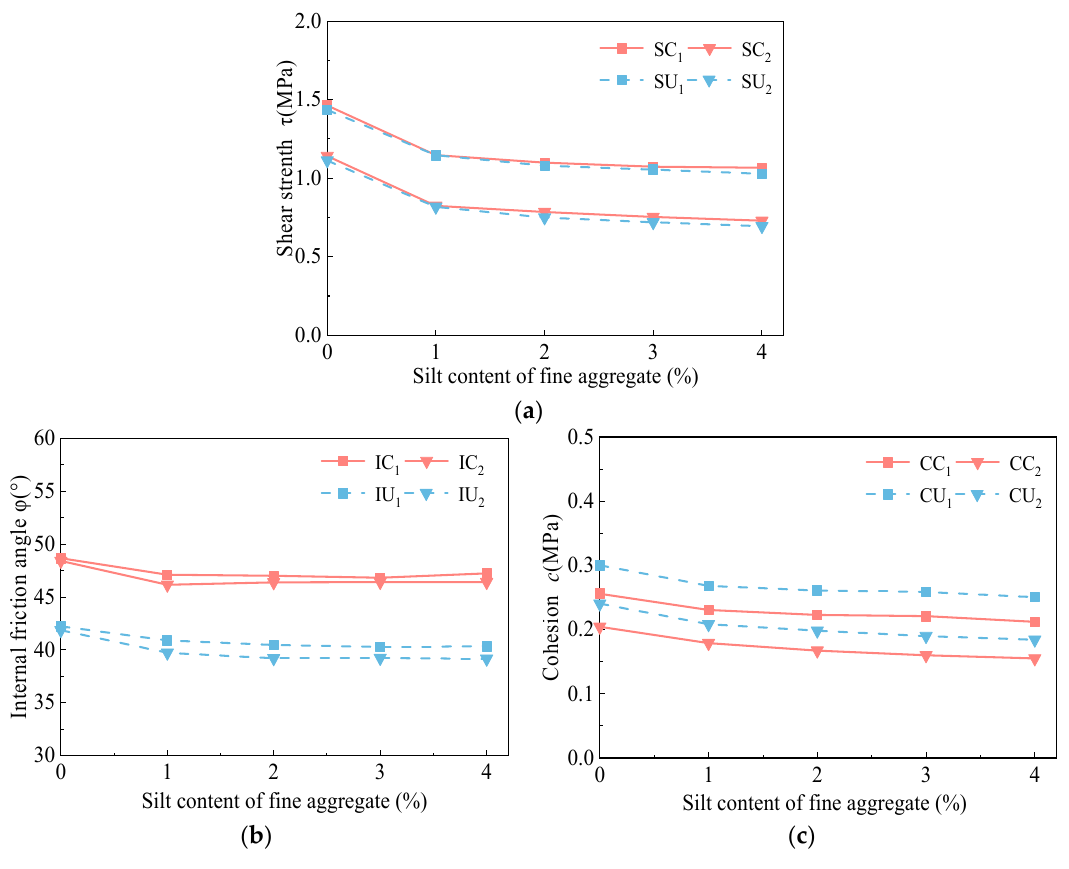
Figure 11. Shear strength, internal friction angle, and cohesion of fine aggregate containing silt specimen before and after high-temperature immersion Marshall test. ( a ) Shear strength; ( b ) Internal friction angle; ( c ) Cohesion.